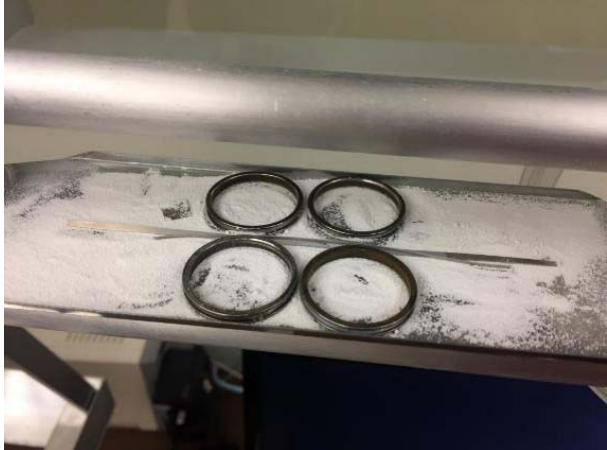
Figure 13. Ring cores on a molybdenum loading plate in a loading chamber. Alumina powder prevented the ring cores from welding to the plate.